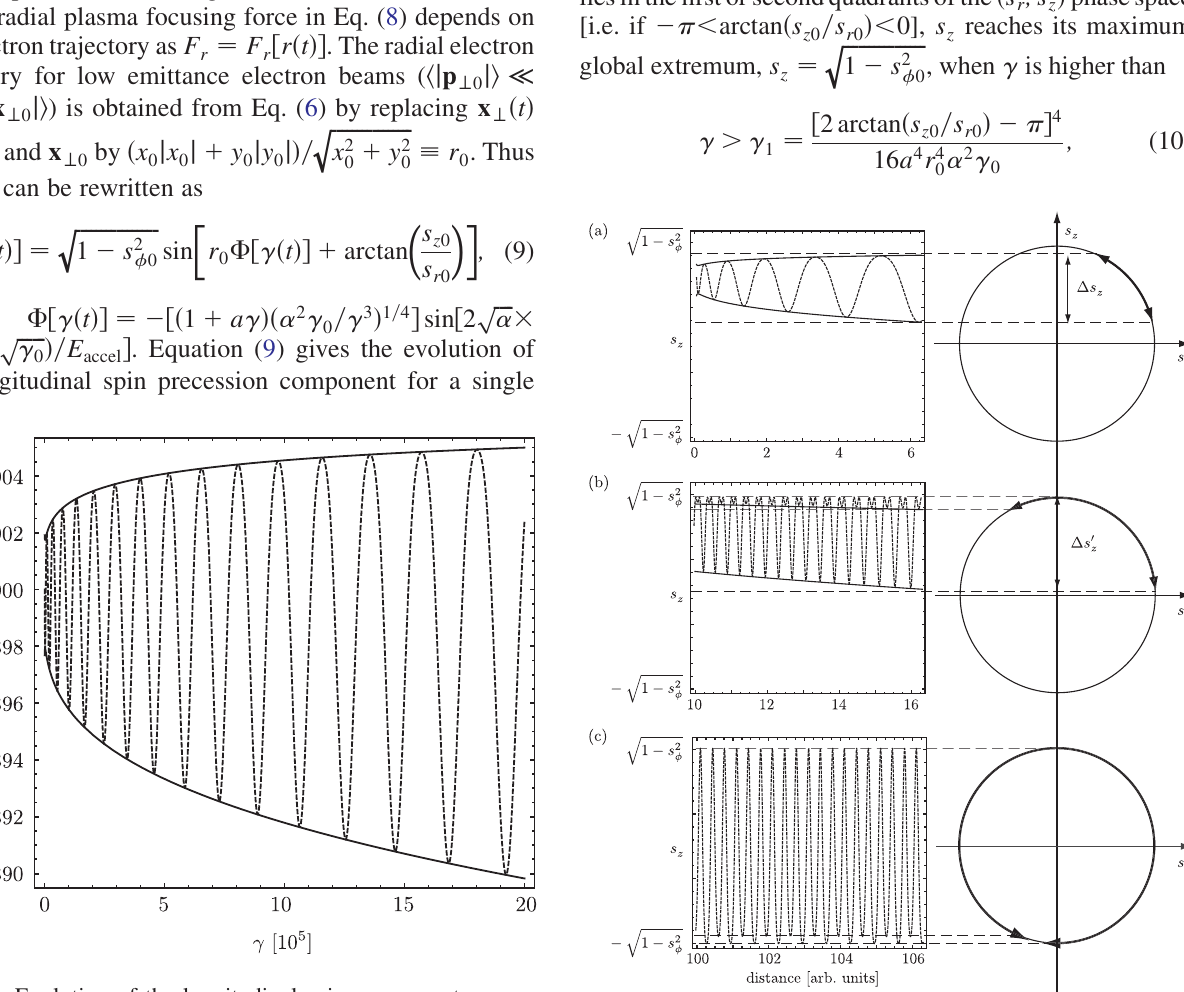
FIG. 1. Evolution of the longitudinal spin component s as a z function of (cid:3) for a single electron with zero initial velocity, with ¼ 0 : 5 c=! ¼ 10 3 , s ¼ 0 : 9 , and s ¼ 0 : 1 . The solid FIG. 2. Qualitative temporal evolution of s (solid-gray lines) r , (cid:3) z p z 0 r 0 0 0 ð t Þ for (cid:3) < (cid:3) < , (b) for (cid:3) during acceleration. Part (a) shows s lines denote the envelope of the oscillations. The dashed lines z 1 1 ð t Þ . The amplitude of the oscillation is on the order of (cid:3) < (cid:3) , and (c) for (cid:3) > (cid:3) . The solid-black lines are s max = min z . represent s 2 2 z The circumferences show the possible trajectories of the spin in = 100 for an electron accelerating to 1 TeV, indicating the s z 0 Þ phase space for constant s ; s . The arches on top the ð s potential of plasma based accelerators to accelerate polarized z r (cid:5) Þ for the time frame correspondent ; s represent the trajectory ð s is equal to the electron beams. The period of the oscillation of s z z r betatron oscillations period. to the left